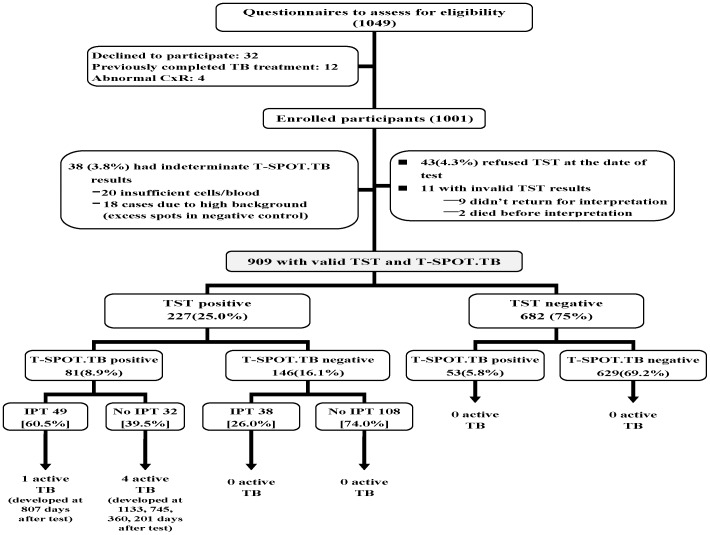
Flow chart showing 909 HIV-infected individuals recruited for final analysis.T-SPOT.TB  = (commercial form of interferon-gamma release assay from Oxford Immunotec, Abingdon, UK); TST =  tuberculin skin test; IPT = isoniazid preventive therapy.